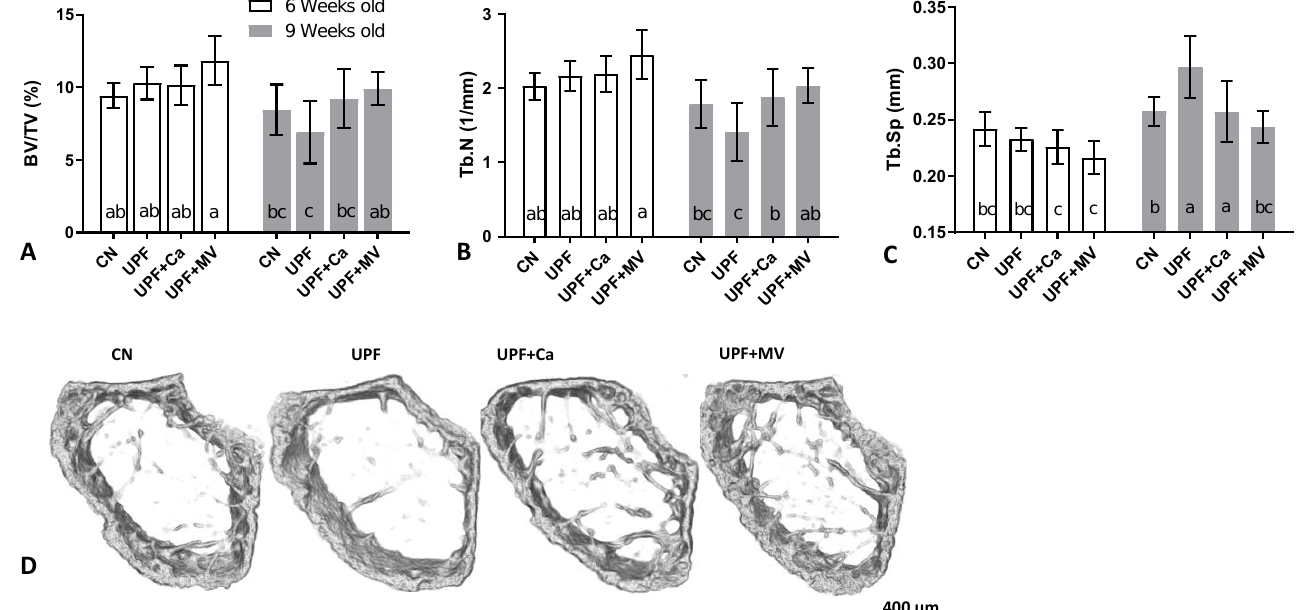
Figure 3. UPF effect on trabecular compartment of mice at 6 and 9 weeks of age. ( A ) Trabecular bone volume (%) ( B ) Trabecular number (1/mm) ( C ) Trabeclular separation (mm) ( D ) 3D reconstruction of trabecular compartment at 9 weeks of age. Values are expressed as mean ± SD, n = 8. Different letters denote p < 0.05 between groups. CN – control, UPF – ultra processed food, UPF+Ca - ultra processed food supplemented with calcium, UPF+MV - ultra processed food supplemented with multivitamin and mineral complex.